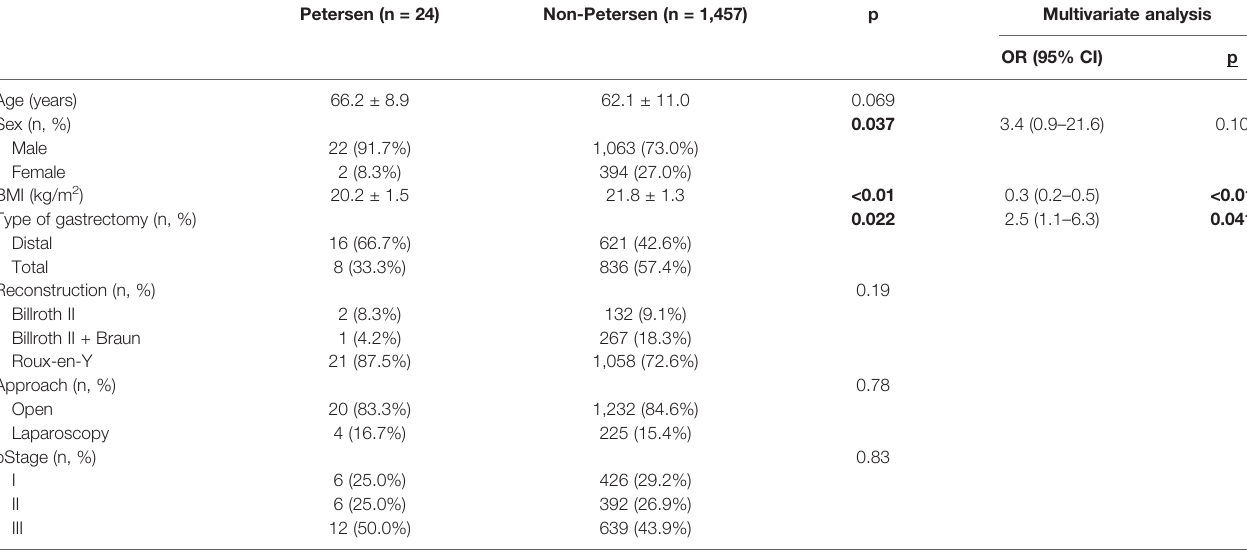
TABLE 1 | Univariate and multivariate analysis for risk factors for Petersen ’ s hernia.